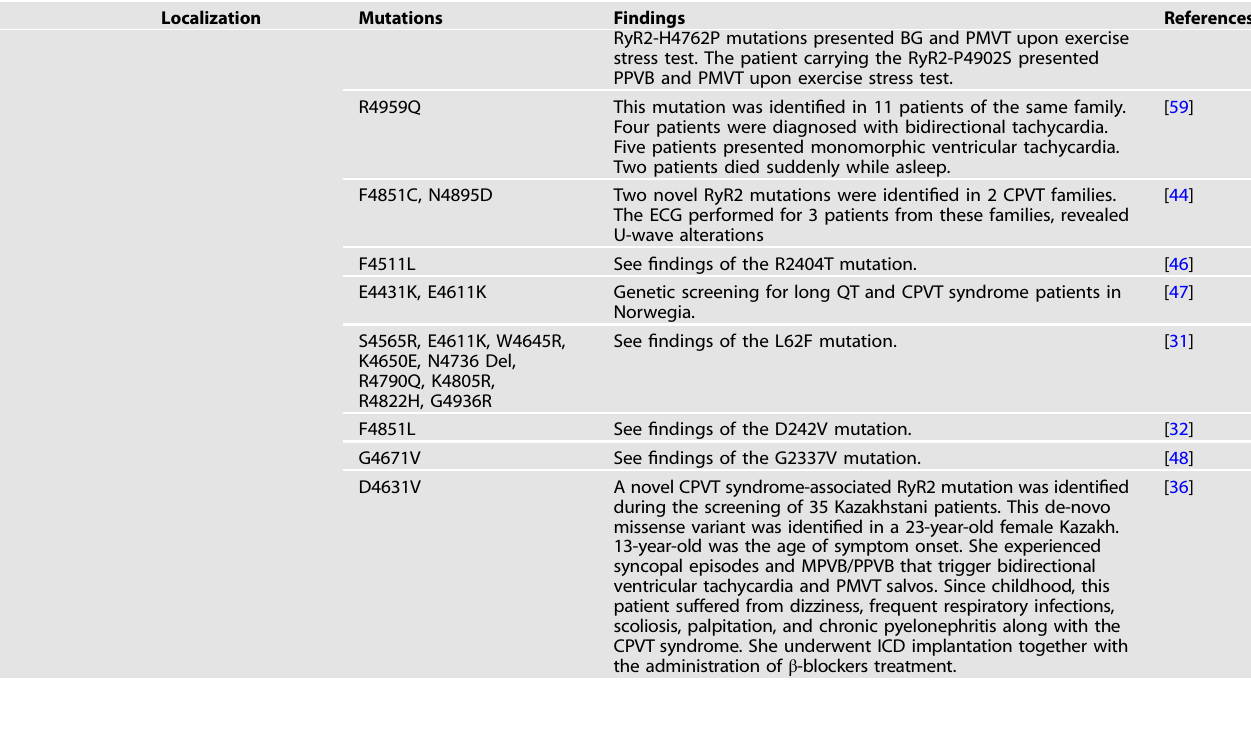
Table 2. List of CPVT1 syndromes modeled using the hiPSC-CMs.